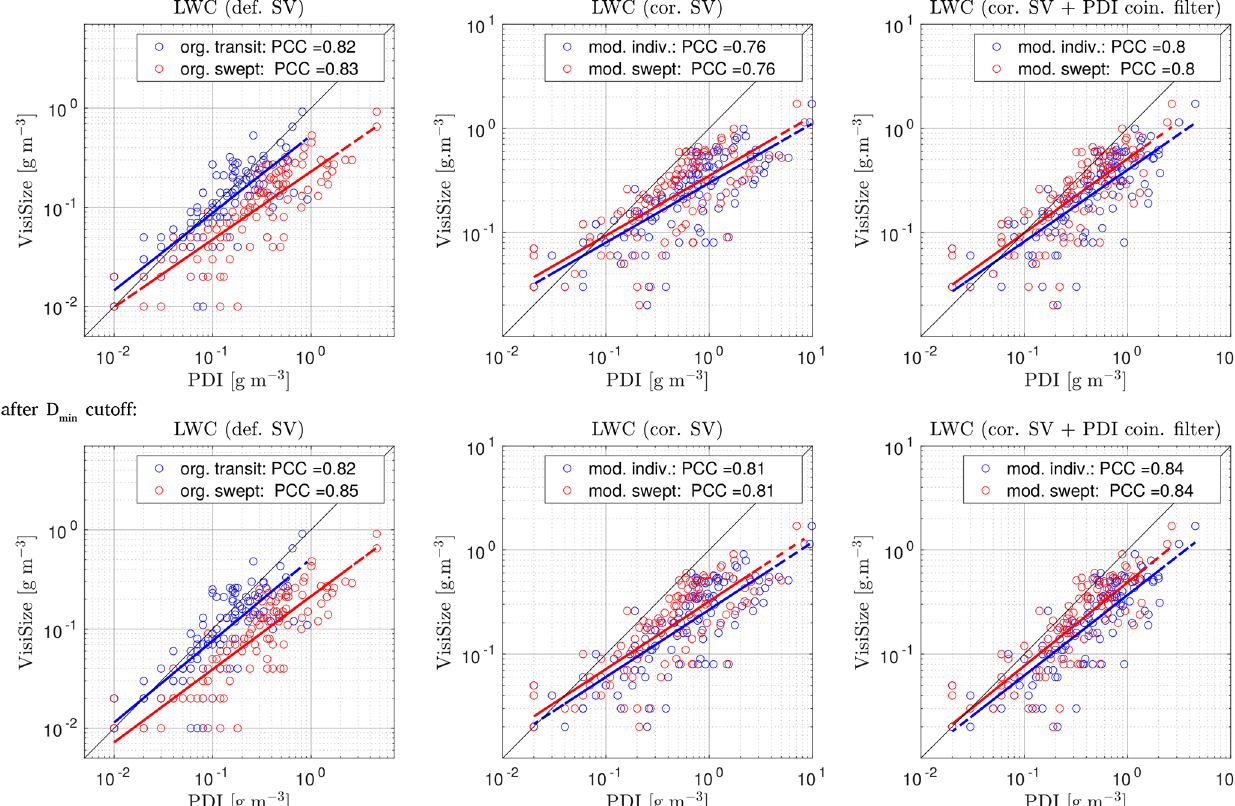
Figure 13. Comparison of the LWC results between the VisiSize and the PDI probe. From the top left to top right, the plots show the raw data (based on the default sample volume for the VisiSize and the original DNC methods for the PDI), the data after modification, and the modified data after applying the coincidence filter to the PDI results. The scatter plots after applying the D min cutoff are shown in the second row. Each PDI method for the LWC computation is shown with a different color within the plots (each pair of blue and red circles: a selected measurement of ∼ 15min). Dashed blue/red lines show the LSR, and the PCCs are displayed in the